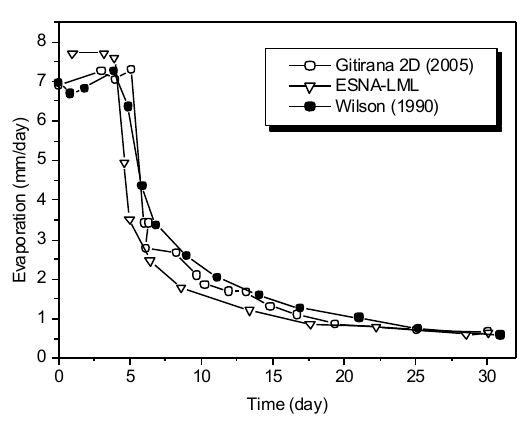
Figure 3a. Verfication of the numerical model on the test of Wilson (1990) : Evaporation variation